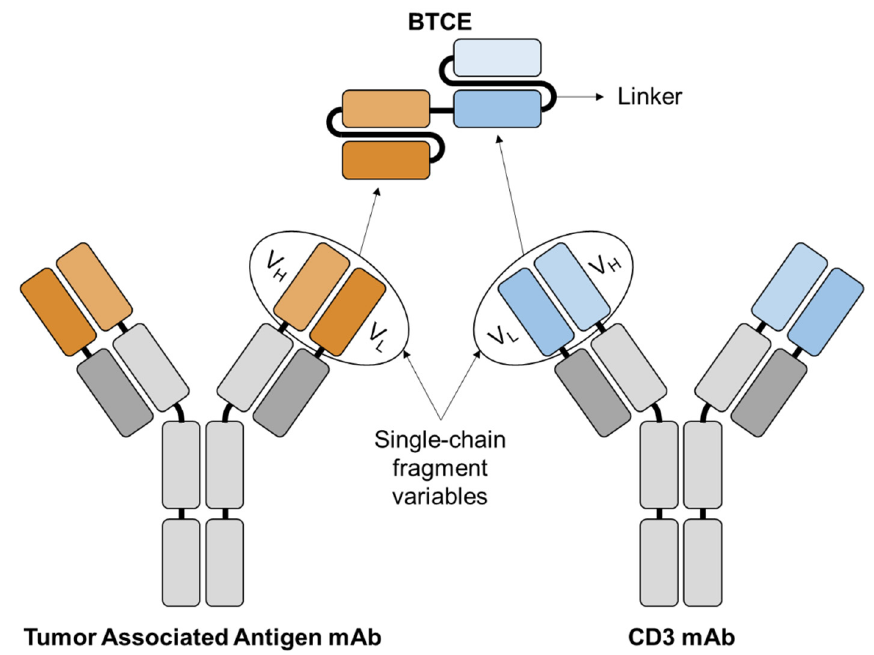
Figure 1. Creation of the BTCE using scFvs of two monoclonal antibodies (mAbs) linked together using a protein linker. The anti-tumor associated antigen scFv specifically recognizes the desired TAA on the tumor cell while the anti-CD3 scFv recognizes the CD3 molecule on the T cell. This enables a highly specific and bivalent system for T cell-based immunotherapy.